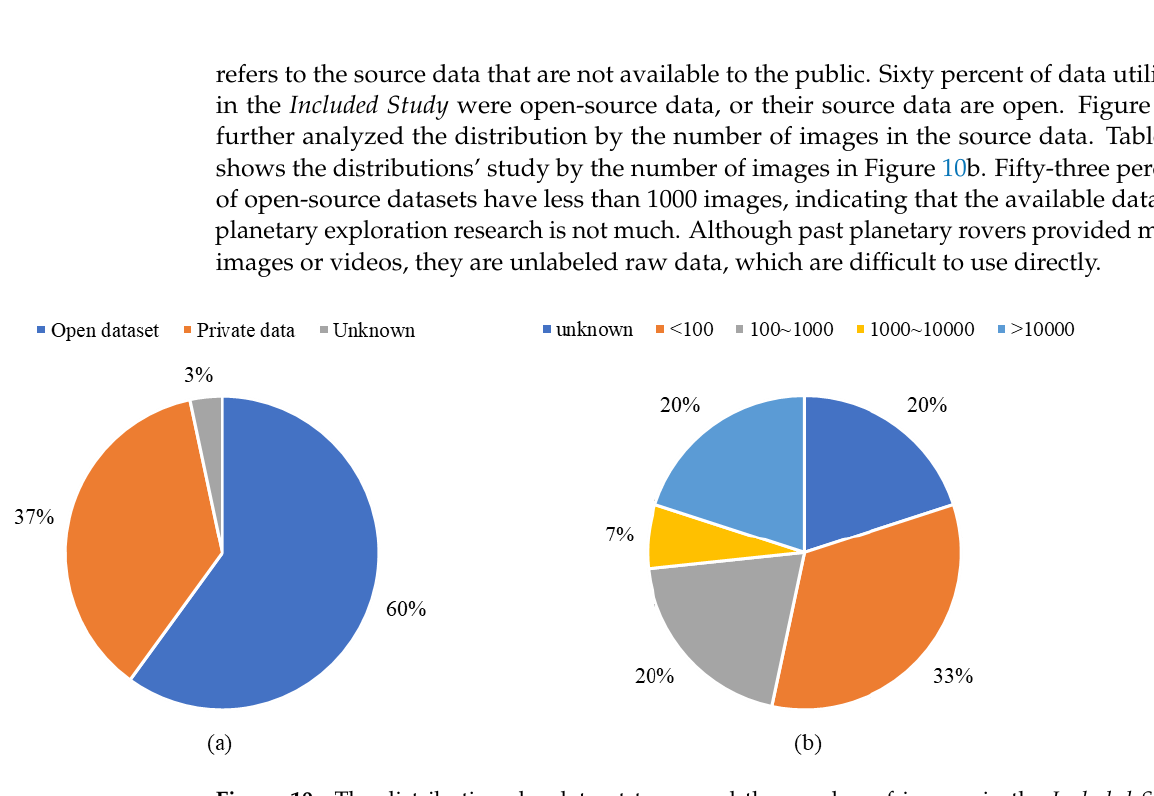
Figure 10. The distributions by dataset types and the number of images in the Included Study . ( a ) Refers to the distribution by dataset type, and ( b ) refers to the distribution by the number of images in the source data. Table 11. The study of the distributions by dataset types in Figure 10a.